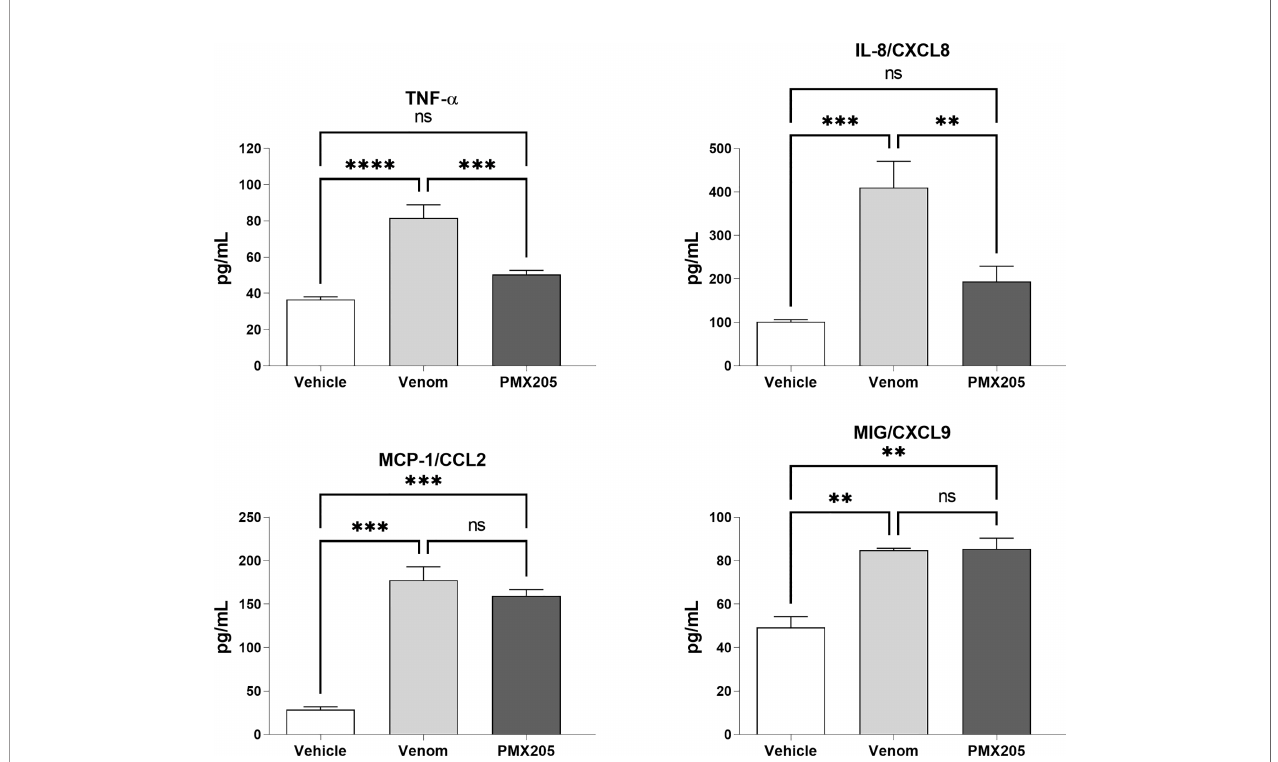
FIGURE 9 | TNF- a and chemokine levels in human blood stimulated by B. jararaca venom in the presence of PMX205. Human blood samples containing GPRP (8 mg/mL) were preincubated with PMX205 (10 m M) and then incubated with B. jararaca venom (50.0 m g/mL) or sterile saline + 5% glucose solution for 60 minutes at 37°C. After plasma collection and dilution (1:2), the presence of TNF- a and chemokines was evaluated by the Cytometric Bead Array (CBA). The results are presented as the mean ± SD from three independent experiments. ns, not signi fi cant; ** p ≤ 0.005, *** p ≤ 0.0005, **** p <